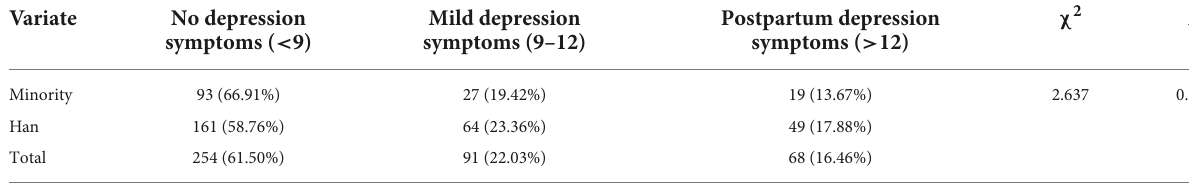
TABLE 3 Means, standard deviations, and correlation between variates.